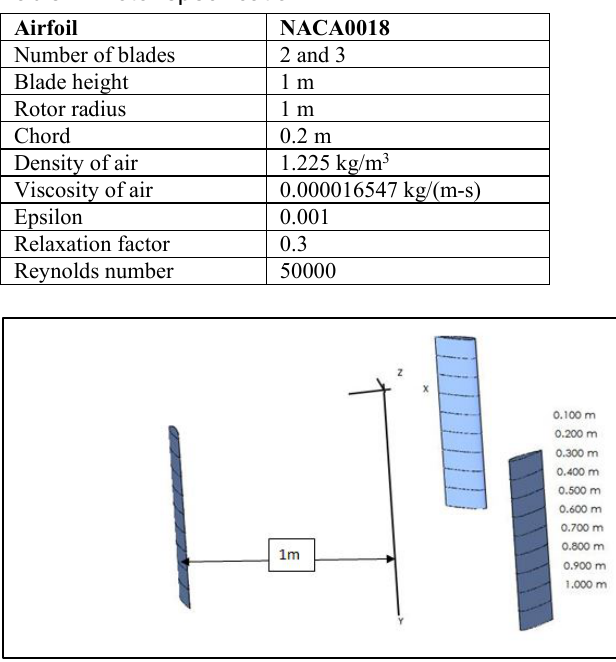
Figure 3. Two-bladed turbine